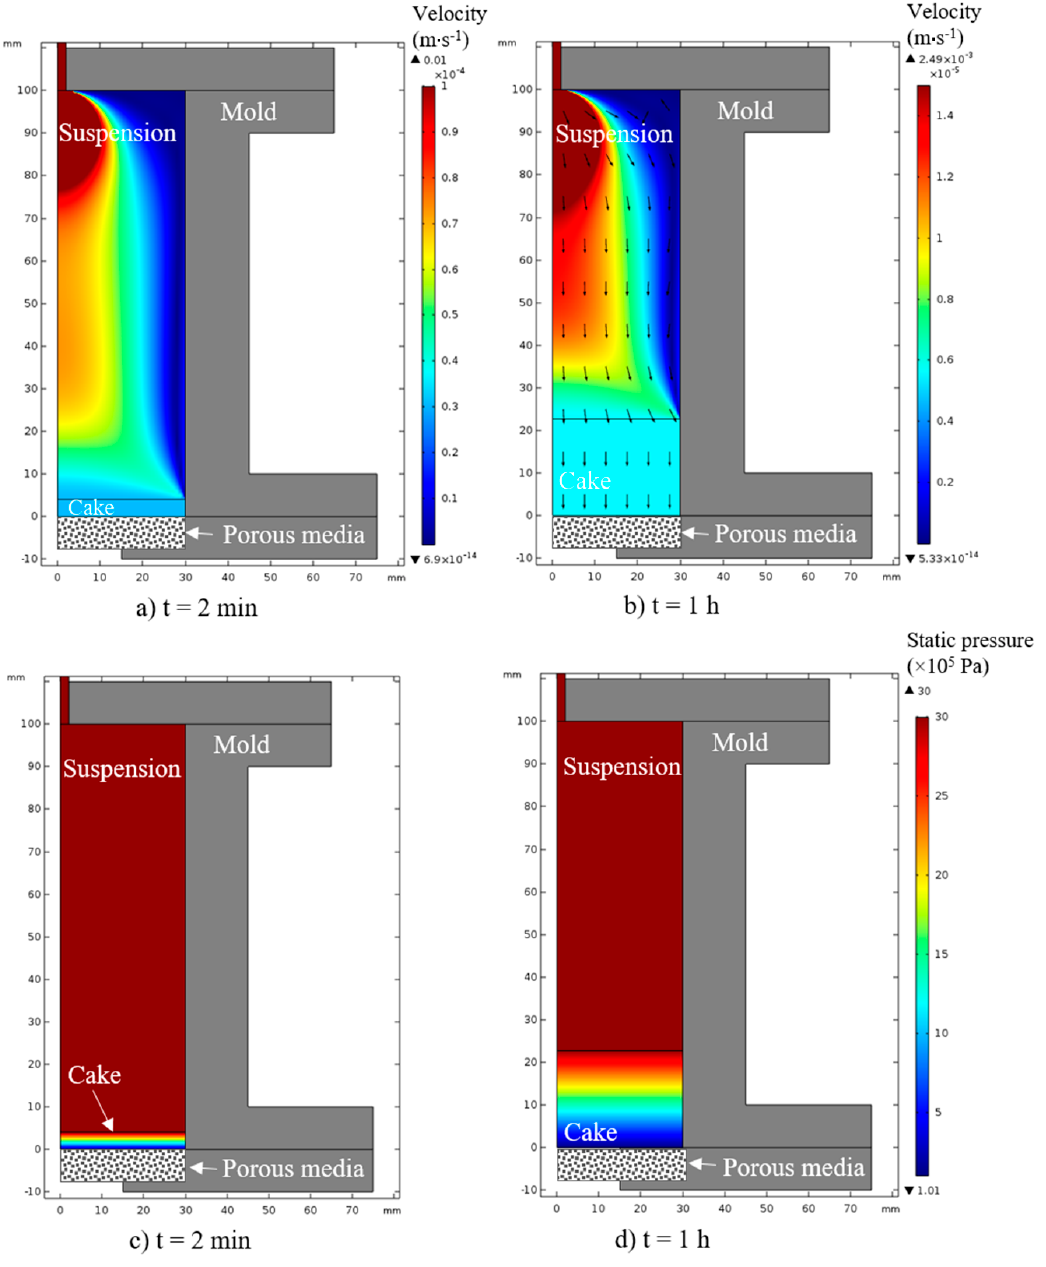
Figure 6. View of the pressure slip-casting system with the simulation result showing the liquid velocity field (magnitude and direction) ( a , b ) or static pressure ( c , d ) at different times of the process: ( a , c ) 2 min and ( b , d ) 1 h. Final cake thickness is 22 mm after 1 h filtration at a pressure of 3 × 10 6 Pa. The flow velocities are very low and decrease during the formation of the green part as the latter creates hydraulic resistance to the flow. These velocities are in the order of 10 − 4 m · s − 1 at t = 2 min and 10 − 5 m.s − 1 at t = 1 h, which is in agreement with a Stock-type laminar flow. In addition, a velocity gradient exists from the wall to the center of the device. This is because the flow velocities were fixed to zero at the surface of the walls of the mold. The numerical model is also capable of predicting pressure fields at any point in the mold and over time. The pressure field is homogeneous at any time in the suspension, as illustrated in Figure 6c,d. Within the cake, a pressure gradient from 3 × 10 6 to 1 × 10 5 Pa is established from the surface of